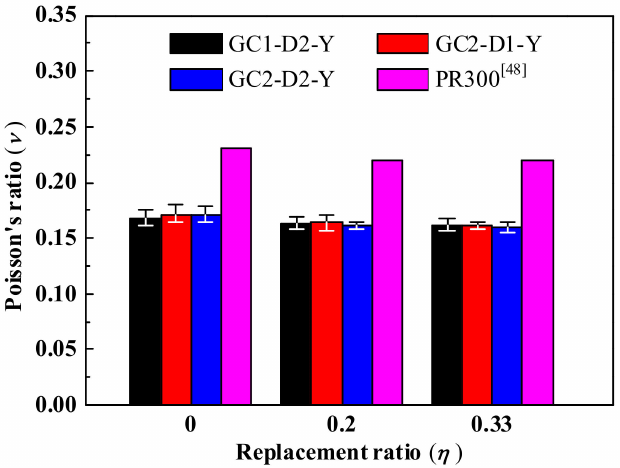
Figure 12. Poisson’s ratio of GRLC specimens and cement compound concrete in Ref. [48] ( λ = 0.4).